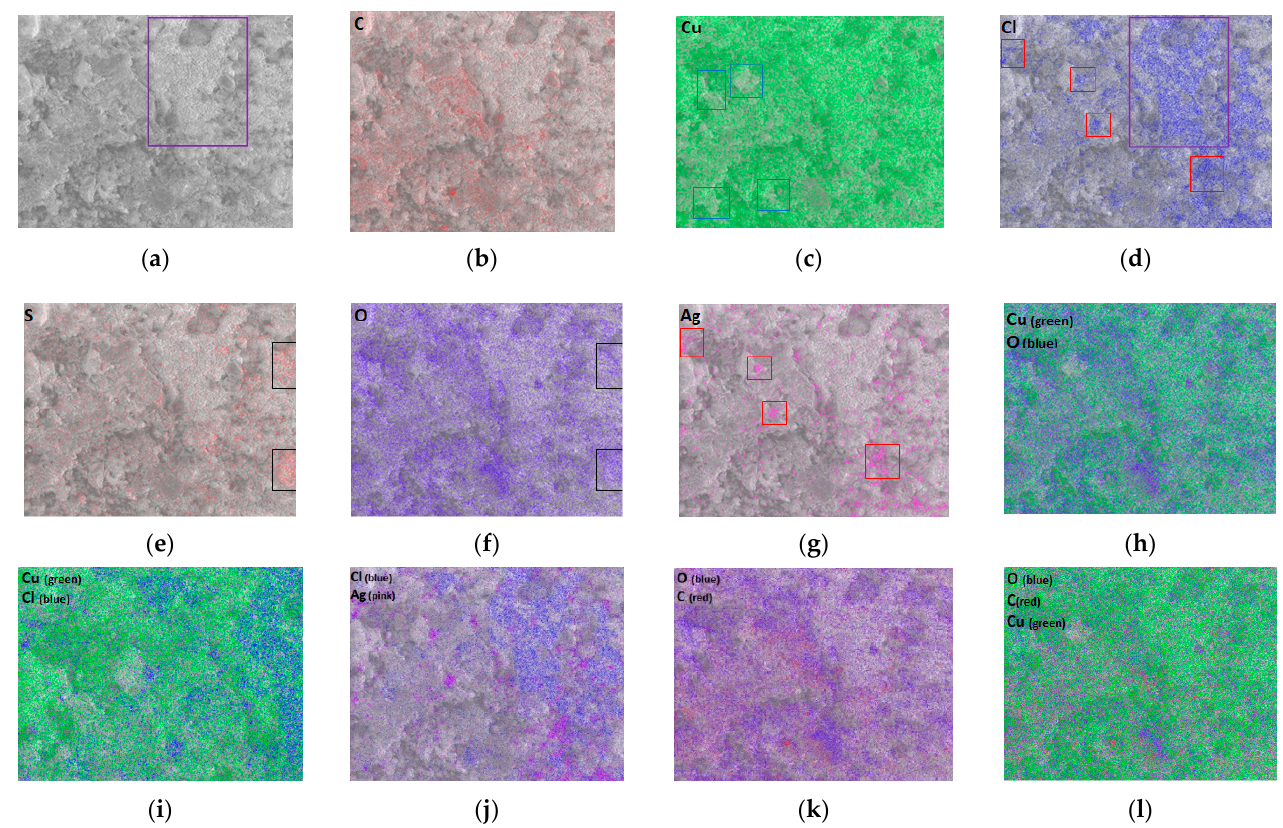
Figure 7. ( a ) Corroded surface, magnification 400×; ( b ) Concentration of C; ( c ) Concentration of Cu; ( d ) Concentration of Cl; ( e ) Concentration of S; ( f ) Concentration of O; ( g ) Concentration of Ag, ( h ) Concentration of Cu (green) and O (blue); ( i ) Concentration of Cu (green) and Cl (blue); ( j ) Concentration of Cl (blue) and Ag (pink); ( k ) Concentration of O (blue) and C (red); ( l ) Concentration of O (blue), C (red) and Cu (green).